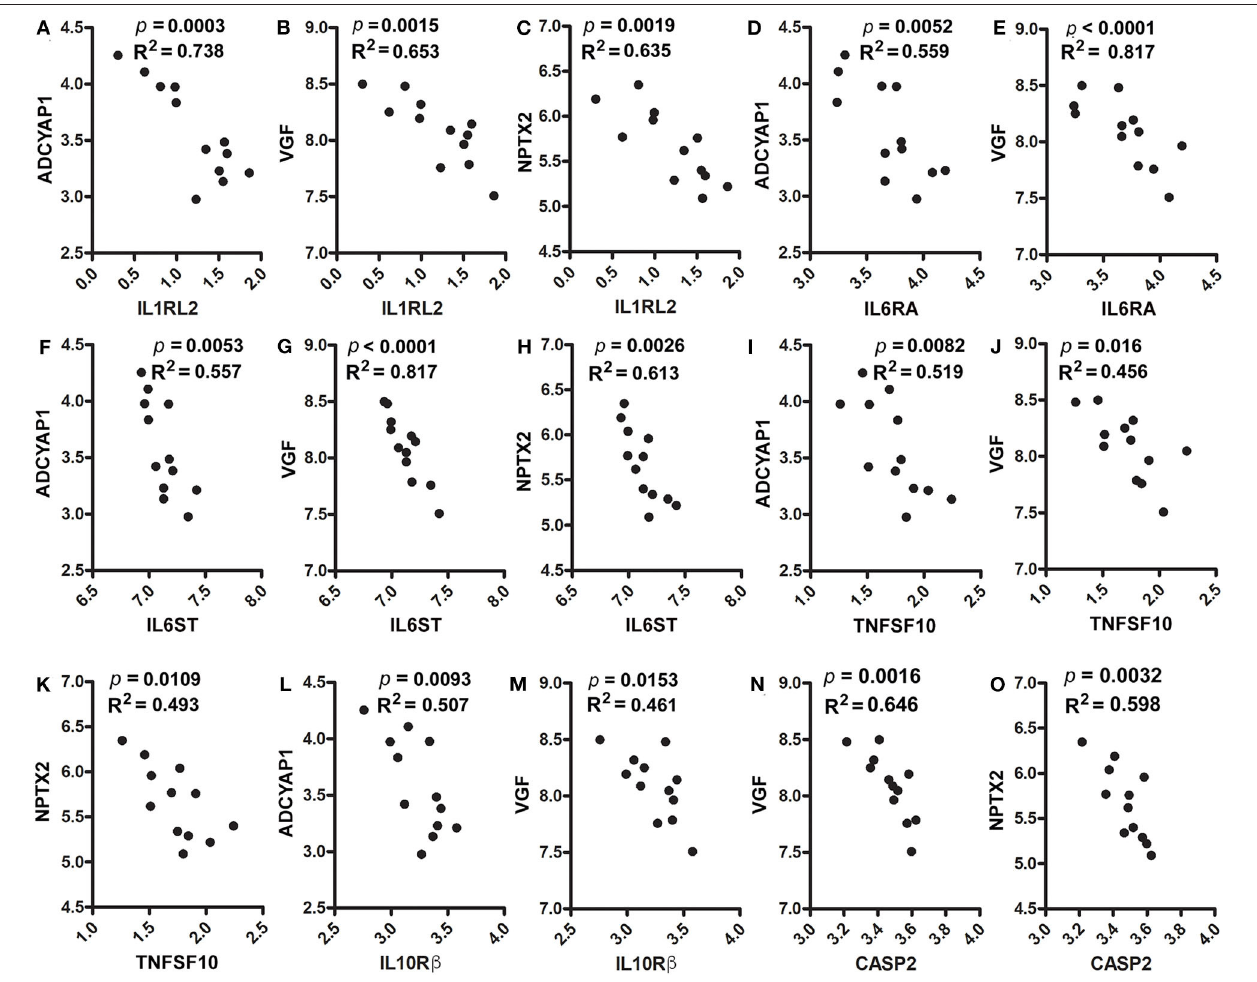
FIGURE 6 | Correlation analysis of ADCYAP1, VGF, and NPTX2 with proinflammatory cytokines, cytokine receptors and caspases. In RNA-Seq data, (A–C). IL1RL2 was inversely correlated with ADCYAP1 ( p = 0.0003, R 2 = 0.738, A ), VGF ( p = 0.0015, R 2 = 0.653, B ), and NPTX2 ( p = 0.0019, R 2 = 0.635, C ). (D,E) IL6RA was inversely correlated with ADCYAP1 ( p = 0.0052, R 2 = 0.559, D ) and VGF ( p < 0.0001, R 2 = 0.817, E ). (F–H) IL6ST was inversely correlated with ADCYAP1 ( p = 0.0053, R 2 = 0.557, F ), VGF ( p < 0.0001, R 2 = 0.817, G ), and NPTX2 ( p = 0.0026, R 2 = 0.613, H ). (I–K) TNFAF10 was inversely correlated with ADCYAP1 ( p = 0.0082, R 2 = 0.519, I ), VGF ( p = 0.016, R 2 = 0.456, J ), and NPTX2 ( p = 0.0109, R 2 = 0.493, K ). (L,M) IL10Rß was inversely correlated with ADCYAP1 ( p = 0.0093, R 2 = 0.507, L ) and VGF ( p = 0.0153, R 2 = 0.461, M ). (N,O) CASP2 was inversely correlated with VGF ( p = 0.0016, R 2 = 0.646 N ) and NPTX2 ( p = 0.0032, R 2 = 0.598, O